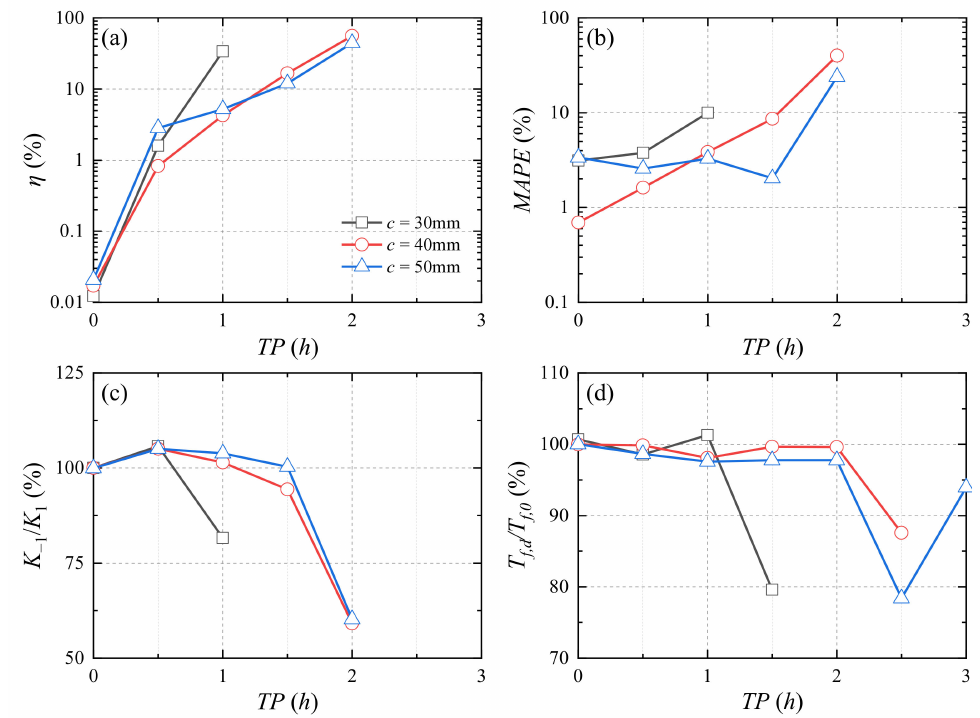
Figure 20. Impact of cyclic load on the response of different cover thickness ( c ) of RC column during fire exposure: ( a ) cyclic load effect coefficient η ; ( b ) MAPE ; ( c ) stiffness degradation ratio; ( d ) fire resistance time